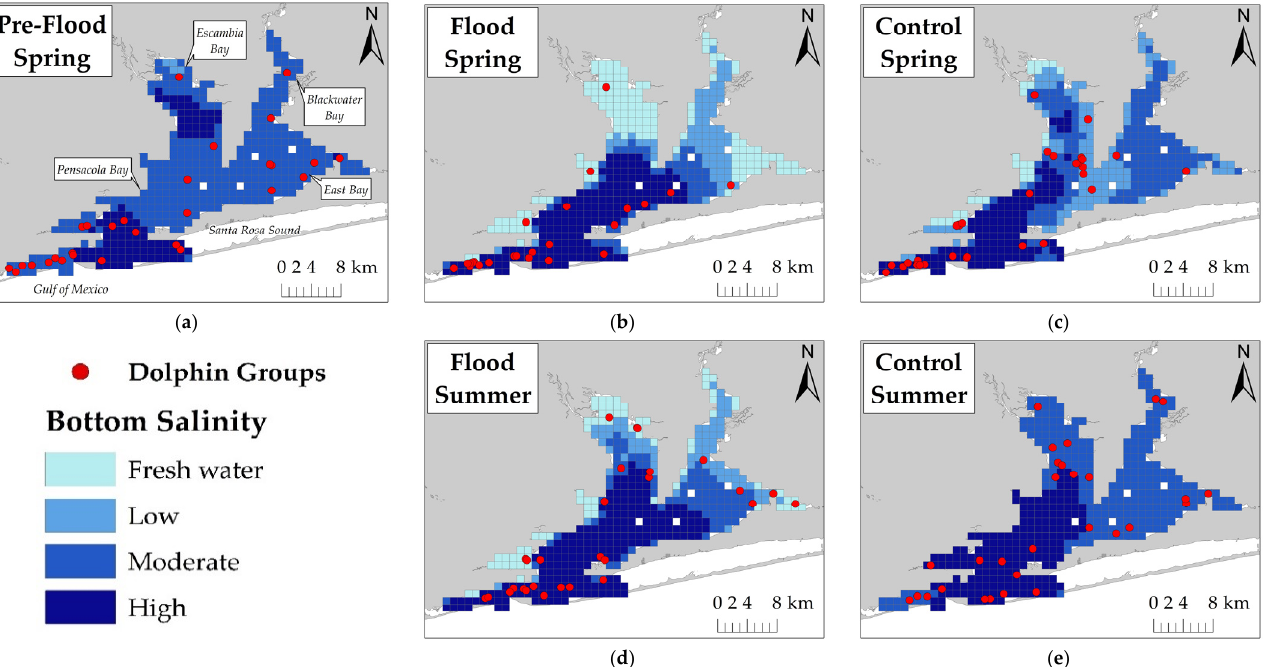
Figure 2. Dolphin group locations (n = 144 groups total) in relation to bottom salinity for: ( a ) Pre-Flood Spring; ( b ) Flood Spring; ( c ) Control Spring; ( d ) Flood Summer; and ( e ) Control Summer. Legend contains symbols for dolphin group locations and bottom salinity categories: Freshwater (<5 ppt), low (5 ‒ 11 ppt), moderate (12 ‒ 20 ppt), and high (>20 ppt). Legend applies to figures ( a – e ).